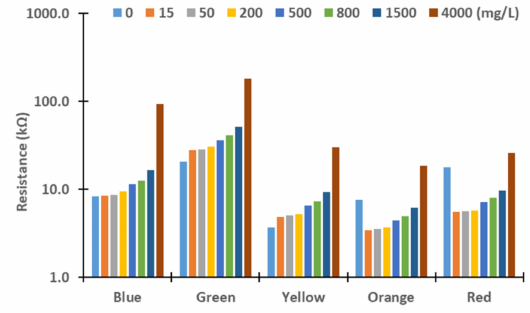
Figure 4. Measured resistance values for sediment.